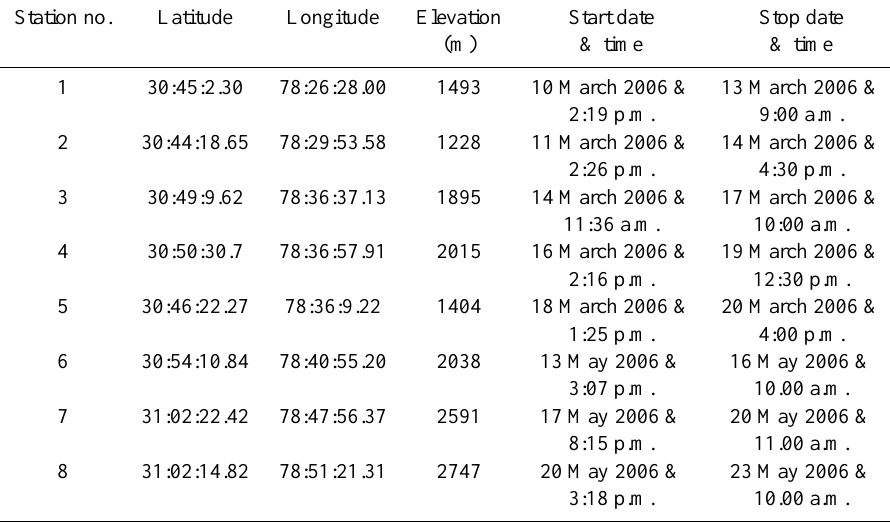
Table 1. GPS location of stations, at which data were recorded from the Garhwal Himalayan region of India along with the duration of record, at each